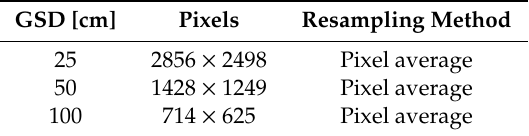
Table 2. Ground sample distance (GSD) and number of pixels after image pre-processing.